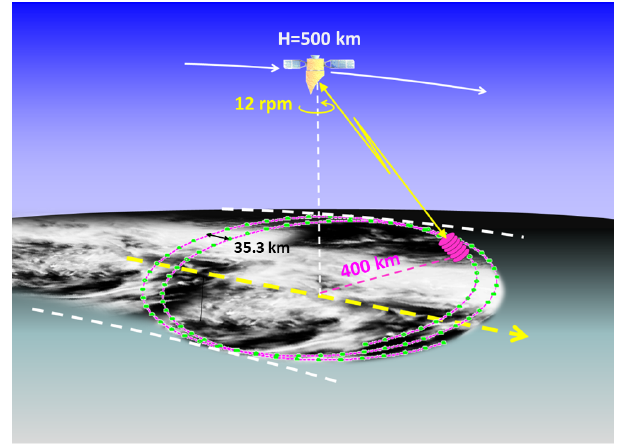
Figure 1. Artistic impression of the WIVERN concept. A 94GHz Doppler radar with 3m antenna scanning at 12rpm tracing out a cycloidal track with an incidence angle of 41.6 ◦